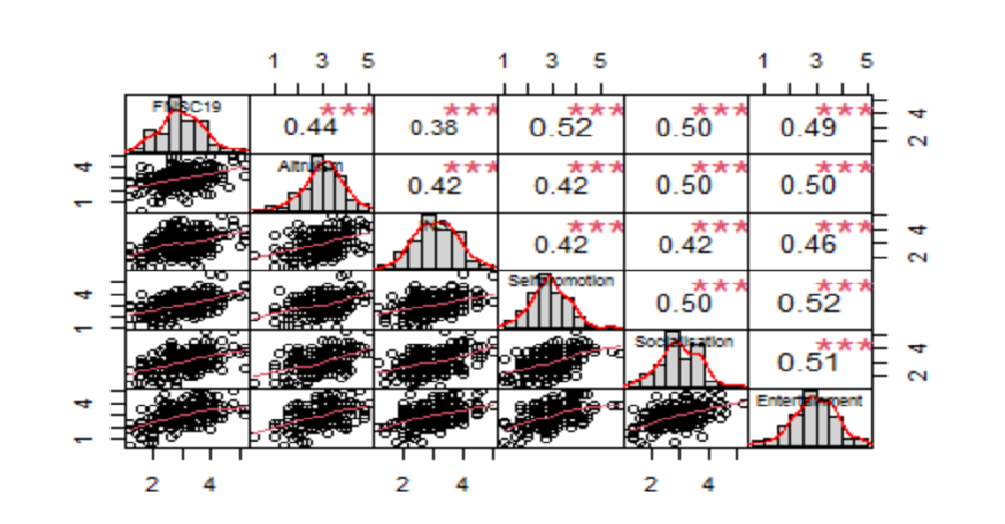
Figure 2: Pearson Correlation Analysis Results (Source: Authors’